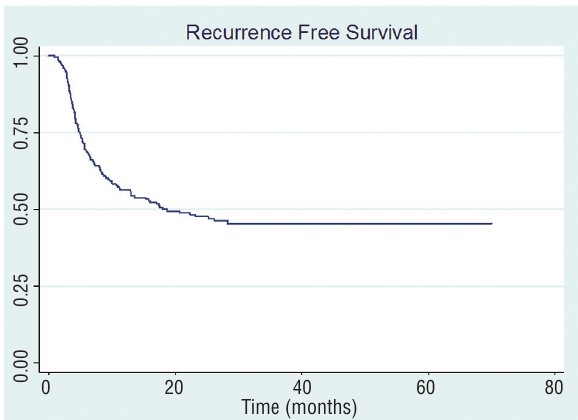
survival.Figure 1 - Kaplan-Meier curve of recurrence free